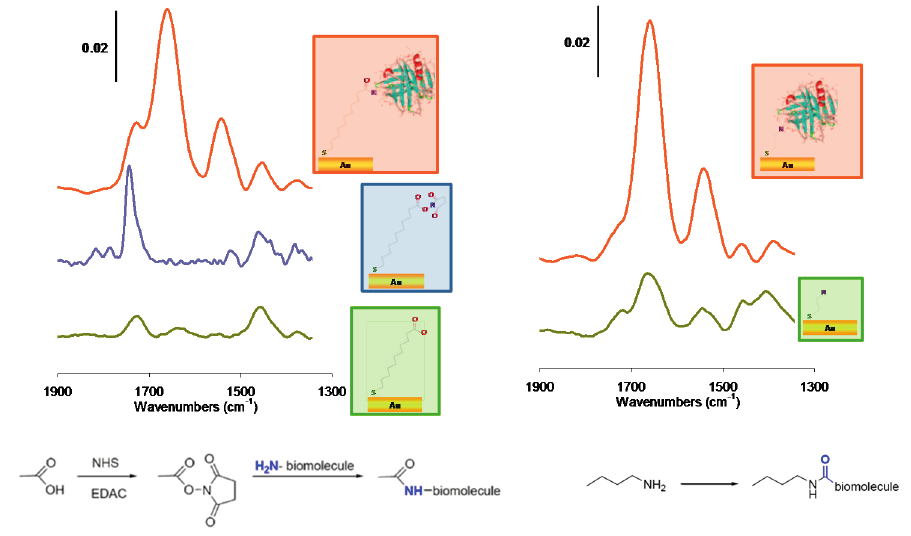
Figure 2. Step by step monitoring of β -lactoglobulin immobilization on acid-terminated SAMs ( left , mercaptoundecanoic acid grafting, activation, then protein immobilization and on amine-terminated SAMs ( right , cysteamine grafting and attachment of activated protein), adapted from reference [24].